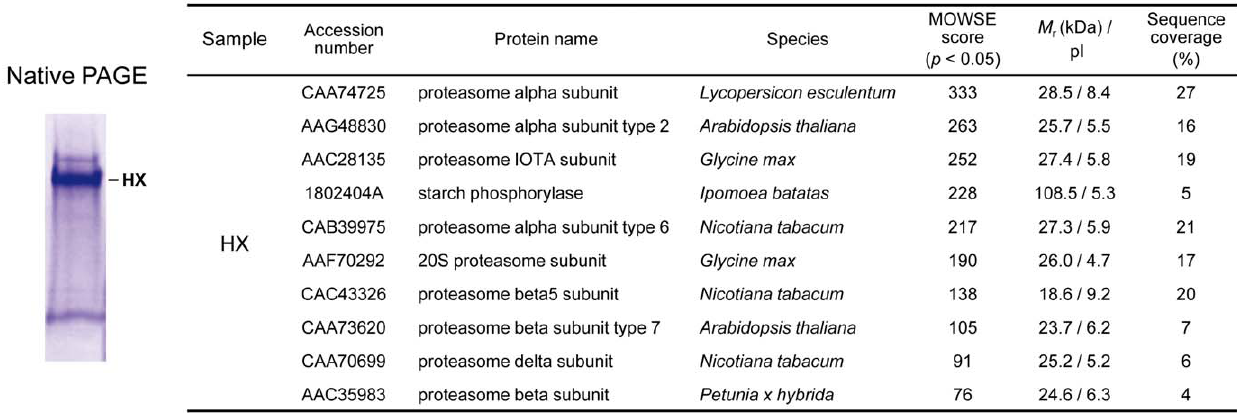
Figure 2. HX is composed of Pho1 and the 20S proteasome. The purified HX was separated by native PAGE and subsequently stained with Coomassie. The single HX band on native PAGE was sliced out for mass spectrometry analysis. The mass spectroscopic results (shown on the right) revealed that HX is composed of starch phosphorylase (Pho1) and several 20S proteasome subunits.